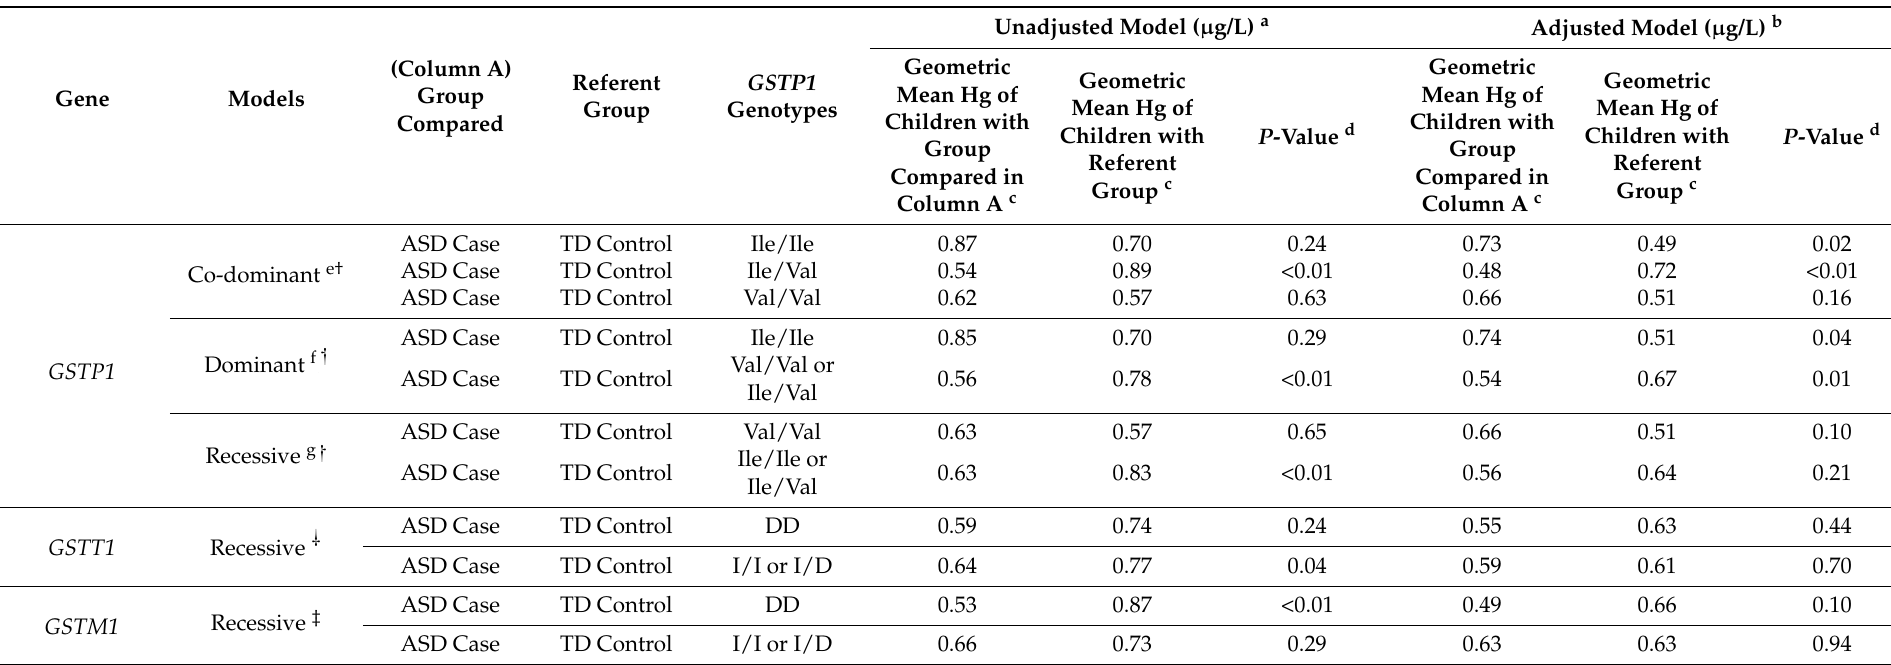
Table 5. Unadjusted and adjusted geometric mean blood mercury concentrations by ASD status (ASD and TD control) based on General Linear Models (GLM) that includes interaction between GST genotypes and ASD case status (ASD and TD control)